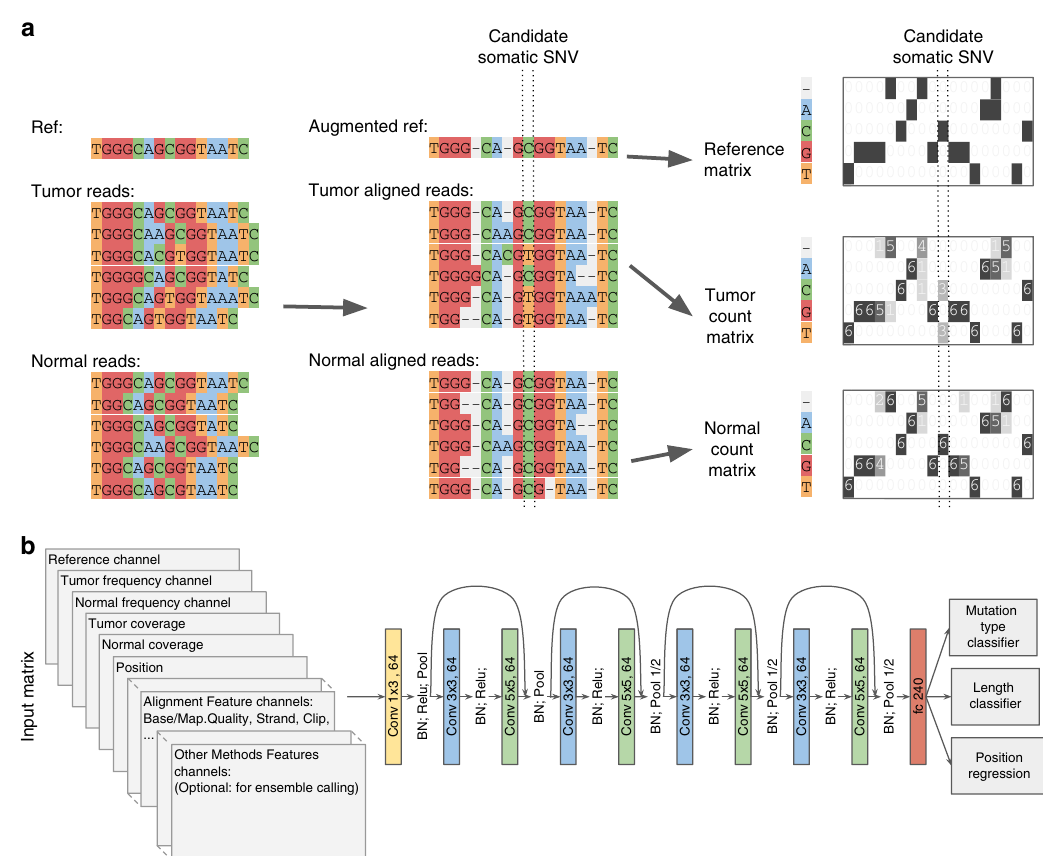
Fig. 1 NeuSomatic overview. a Toy example of input matrix preparation for a given candidate somatic SNV. Sequence alignment information in a window of seven bases around the candidate somatic mutation is extracted. The reference sequence is then augmented by adding gaps to account for insertions in the reads. The augmented alignment is then summarized into the reference matrix, the tumor count matrix, and the normal count matrix. The count matrices record the number of A/C/G/T and gap ( ‘ - ‘ ) characters in each column of the alignment, while the reference matrix records the reference bases in each column. The count matrices are then normalized by coverage to re fl ect base frequencies in each column. Separate channels are reserved to record the tumor and normal coverages. b The input 3-dimensional matrix and the proposed NeuSomatic network architecture. The input matrix consists of reference channel, tumor and normal-frequency channels, coverage and position channels, followed by several channels summarizing the alignment features. When used in ensemble mode, NeuSomatic also includes additional channels for other individual methods features. NeuSomatic network architecture consists of nine convolutional layers structured in four blocks with shortcut identity connections. We use two softmax classi fi ers and one regressor on the fi nal layer to predict the mutation type, size, and